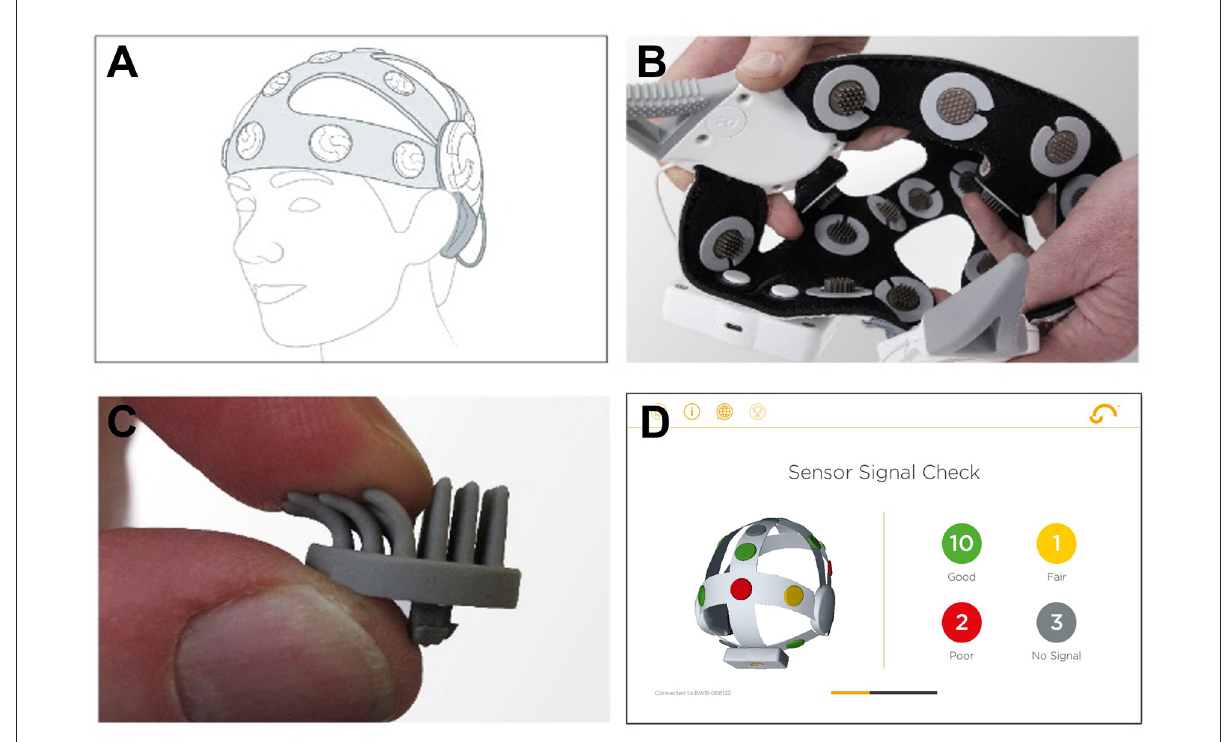
FIGURE3 Cumulus dry EEG recording headset. (A) Positioning of the headset on the head. (B) Interior of the dry EEG cap. (C) Dry EEG electrode. (D) Screenshot of the built-in calibration step in the mobile app. Figure adapted from McWilliams et al.